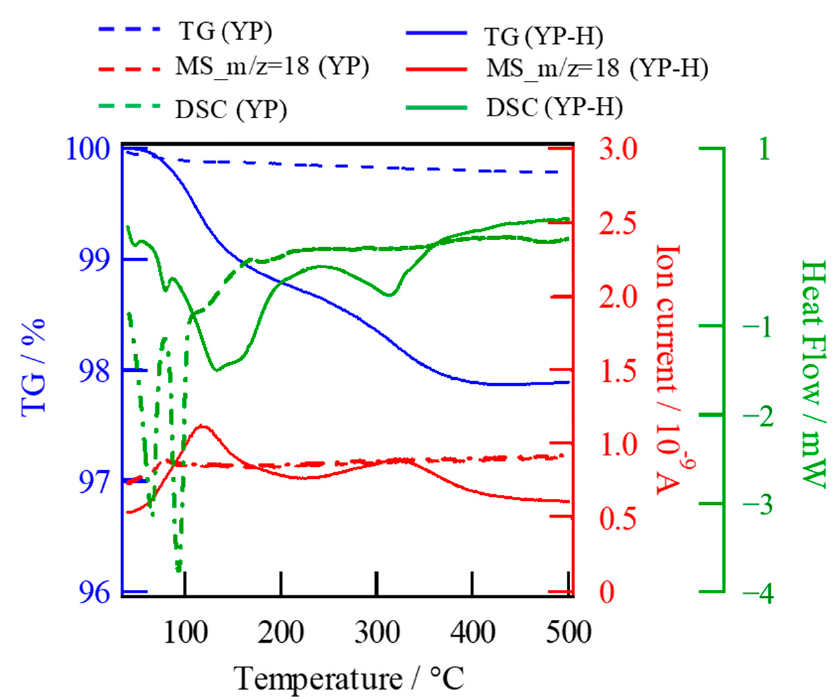
Figure 9. TG-MS and DSC curves measured on Narpsio bulk glass-ceramics before and after ion